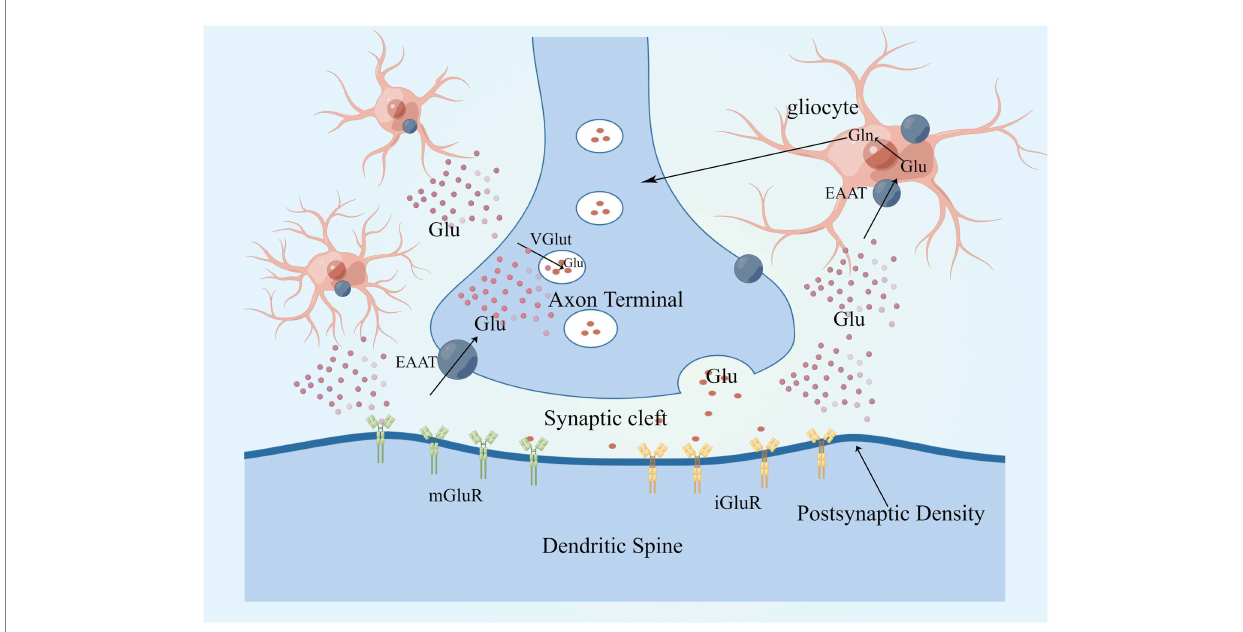
FIGURE 2 Glutamate in neurons is concentrated in synaptic vesicles via VGLUT and is released into the extracellular space in response to neuronal depolarization. There are two main classes of glutamate receptors, that is, mGluRs and iGluRs, glutamate clearance from the extracellular space takes place mostly through the high-affinity EAATs, EAAT 1 and 2 are mainly expressed in astrocytes. Glutamate enters glial cells via EAAT1 and EAAT2, where it is metabolized to glutamine, which is released into the extracellular space and converted to glutamate after uptake by neurons, completing a cycle.